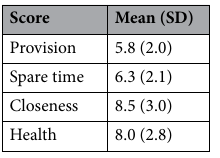
Table 3. Mean and SD f scores based on LISAT-11.